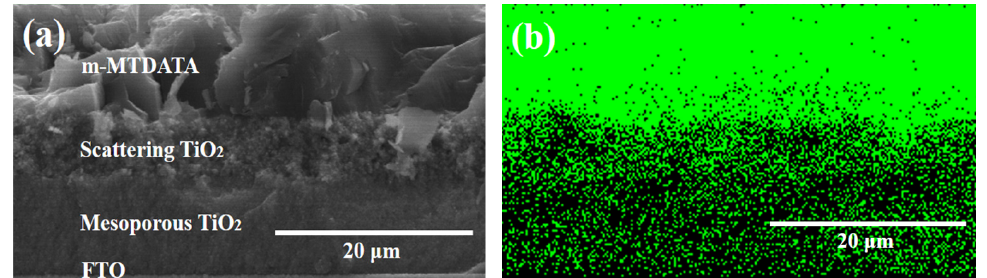
Figure 1. Cross-sectional SEM ( a ) and EDS mapping images showing the distribution of carbon ( b ) in a decapped sDSSC with m-MTDATA. N719 dyes containing carbon atoms were not adsorbed on TiO 2 surface.